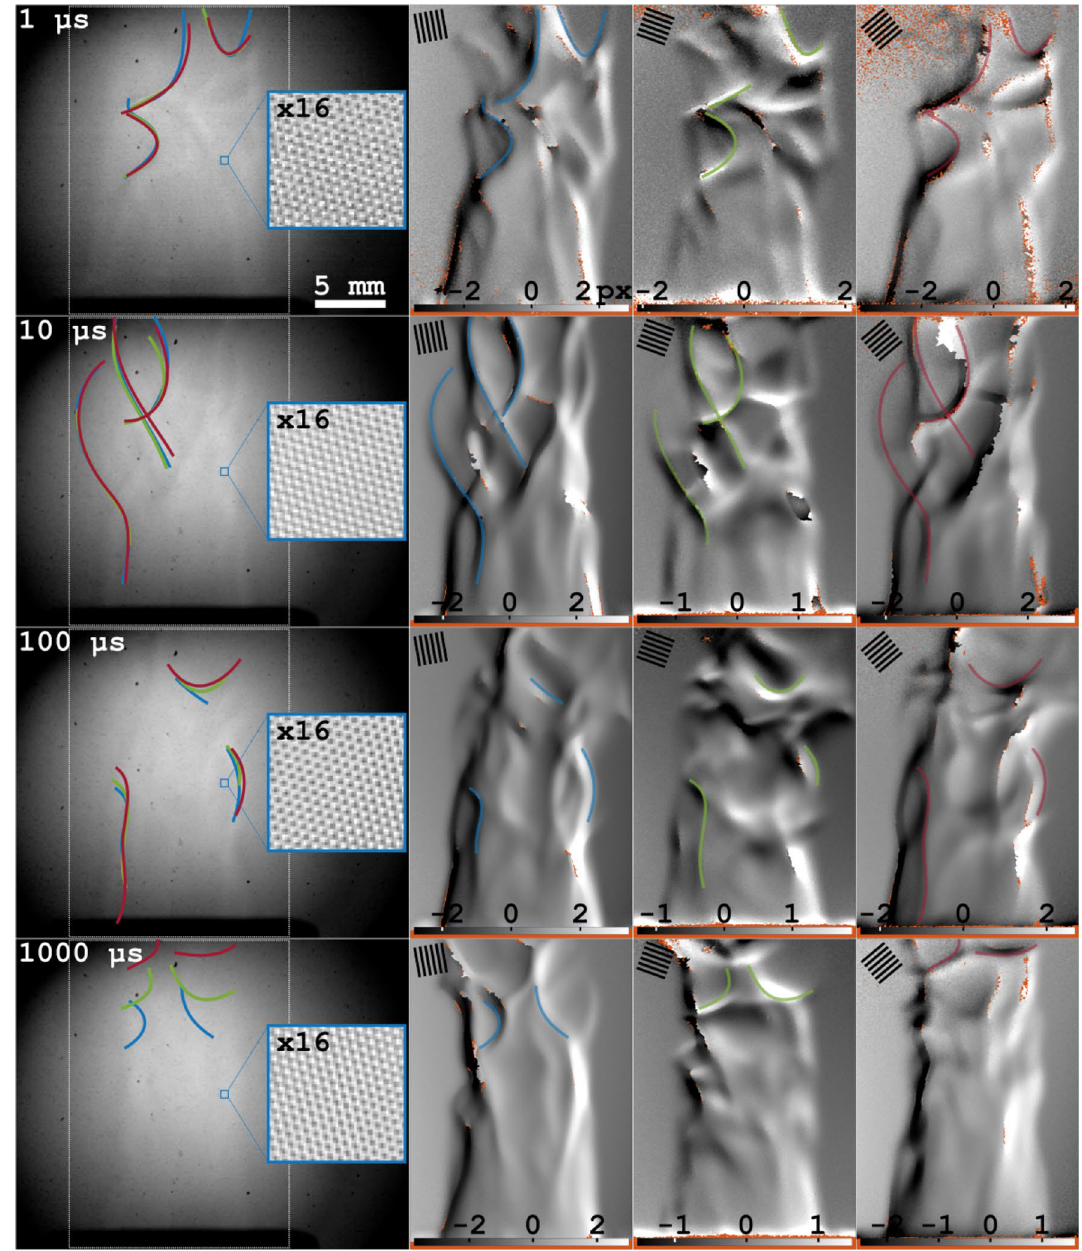
Figure 6. Video sequences of flame induced light displacement. The left column show the original image for each sequence. The blue, green and red lines highlight structures that are considered identical in image 1, 2 and 3, respectively. These colored lines are present both in the original image and in the image they originate from. The inter-frame time of each sequence is shown in the upper left corner of the original image. The orientations of the spatial modulations, used for acquisition, are shown for respective